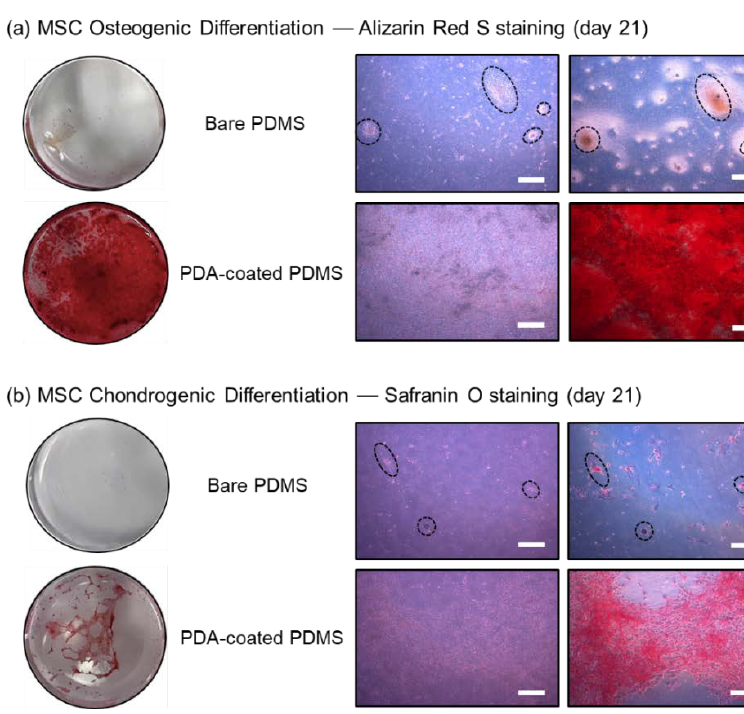
Figure 6. Staining results showing MSC differentiation after 21 days of culture. ( a ) Osteogenic and ( b ) chondrogenic differentiation was evaluated by staining with Alizarin Red S and Safranin O, respectively. The dotted circles and ellipses represent the same spot in the images. Scale bar = 500 μm.